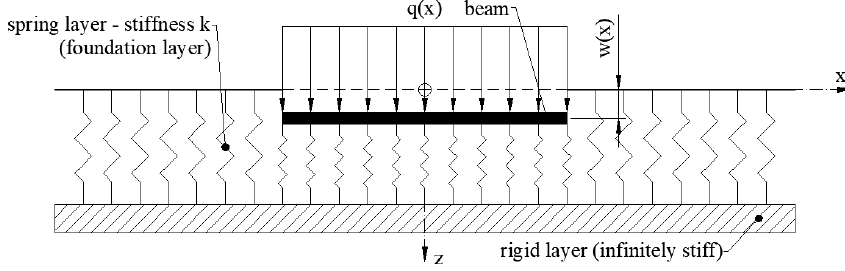
Figure 1. Beam on elastic foundation—Winkler model.